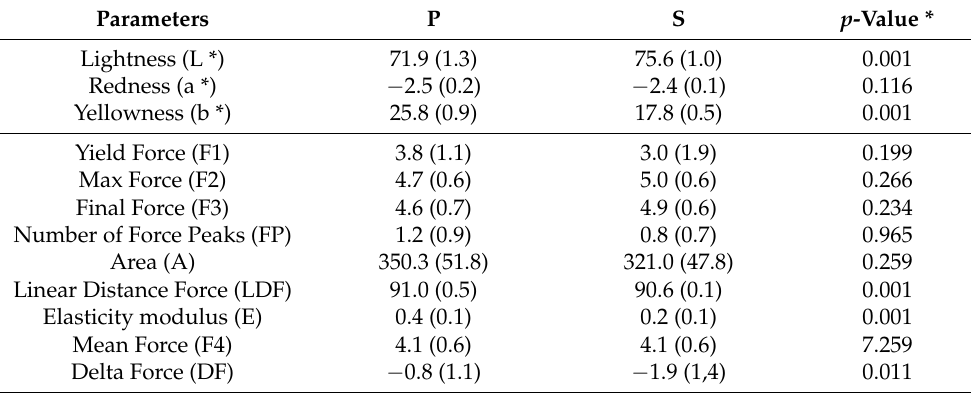
Table 4. Instrumental characterisation of pasture (P) and stall (S) cheese: Means, standard deviations (in parenthesis), and p -values for colour and texture